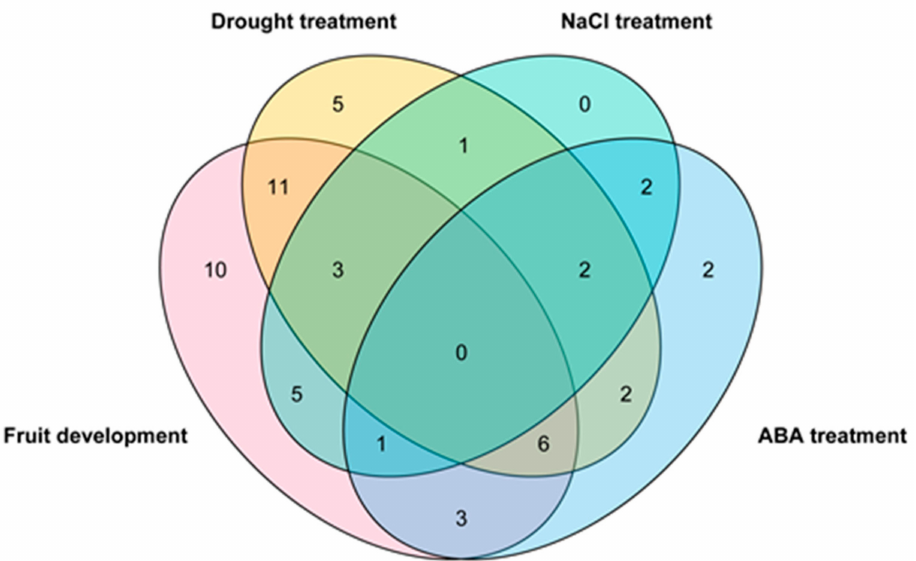
Figure 10. The Venn diagram of ZjWRKY genes related to fruit development, drought, NaCl, and ABA